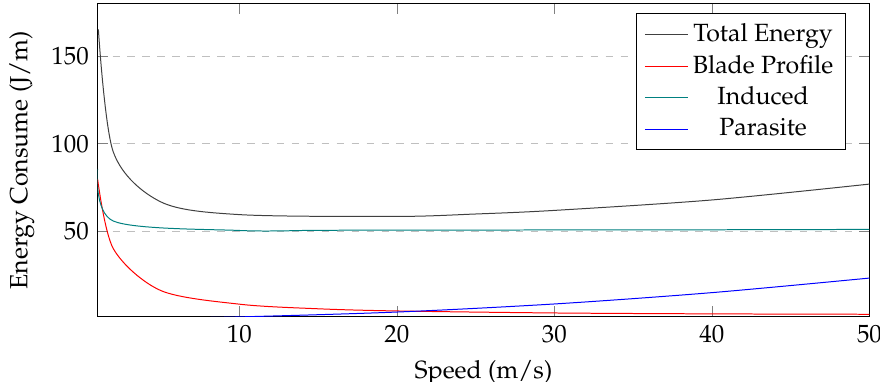
Figure 5. UAV’s Consumed Energy with Respect to Speed.